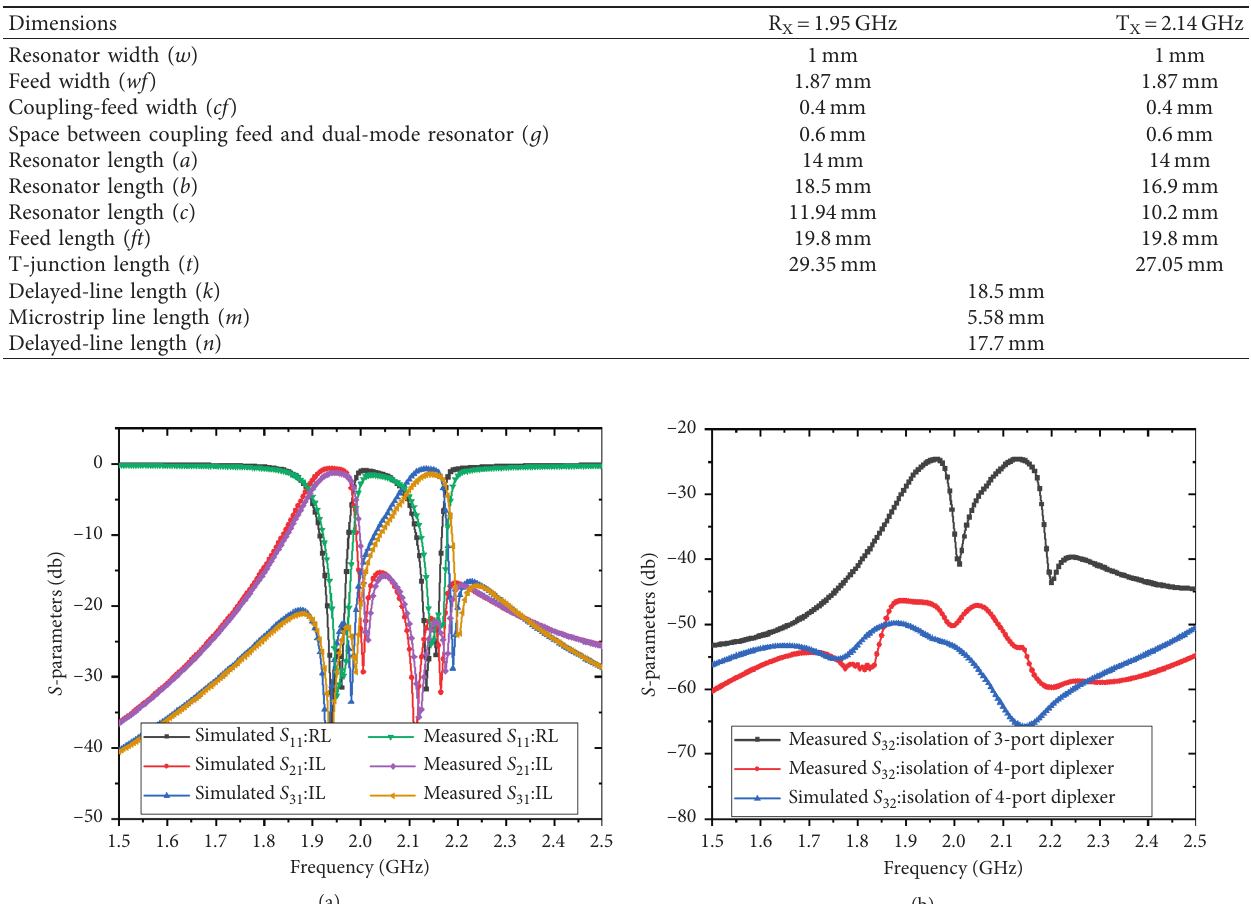
Figure 7: Comparison between simulated and measured results of (a) RL and IL of four-port diplexer and (b) isolation ( S port diplexer and four-port